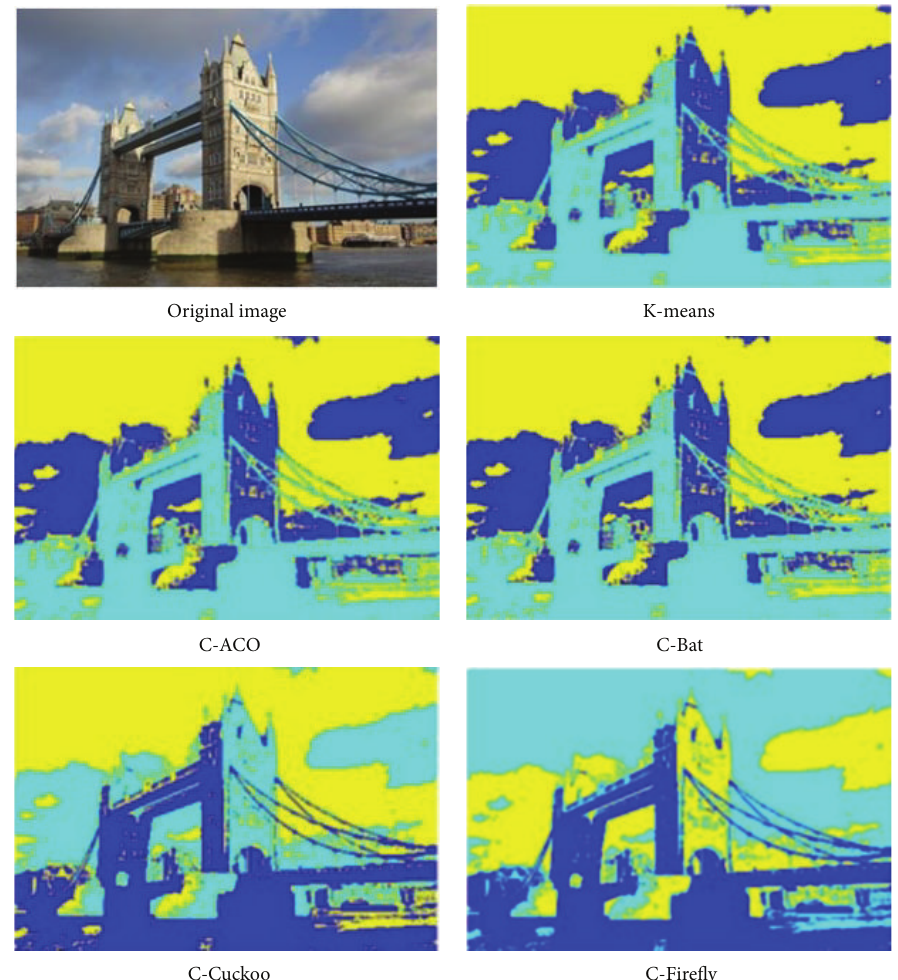
Figure 9: Results of image segmentation by using different nature-inspired clustering algorithms, on a photo called “Tower